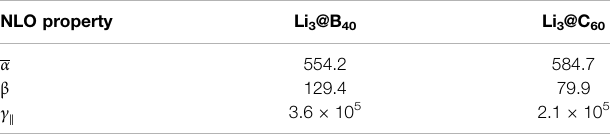
Li 3 cluster of Li 3 @C 60 system as compared to the Li 3 @B 40 system indicates a greater extent of localization of electron density in the Li 3 @C 60 system.